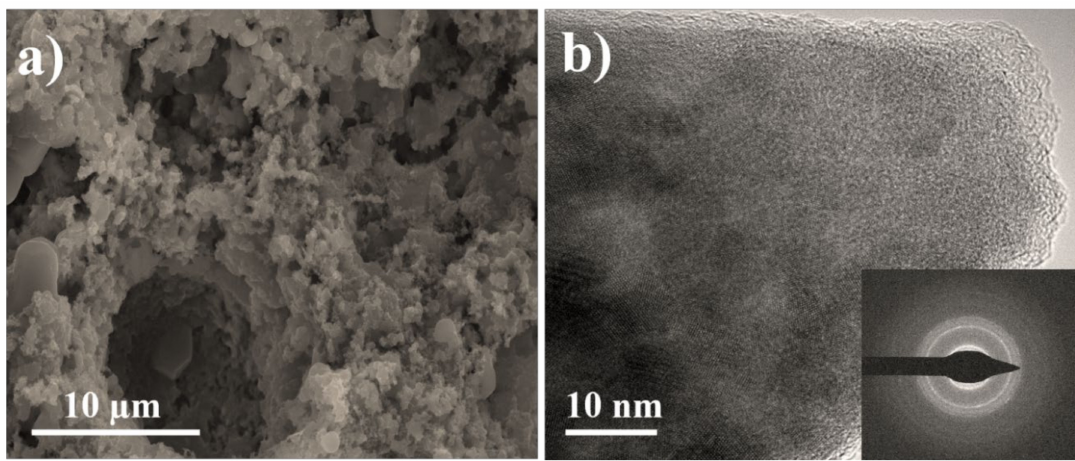
Figure 1. ( a ) FE-SEM and ( b ) HR-TEM (inset as SEAD pattern) images of